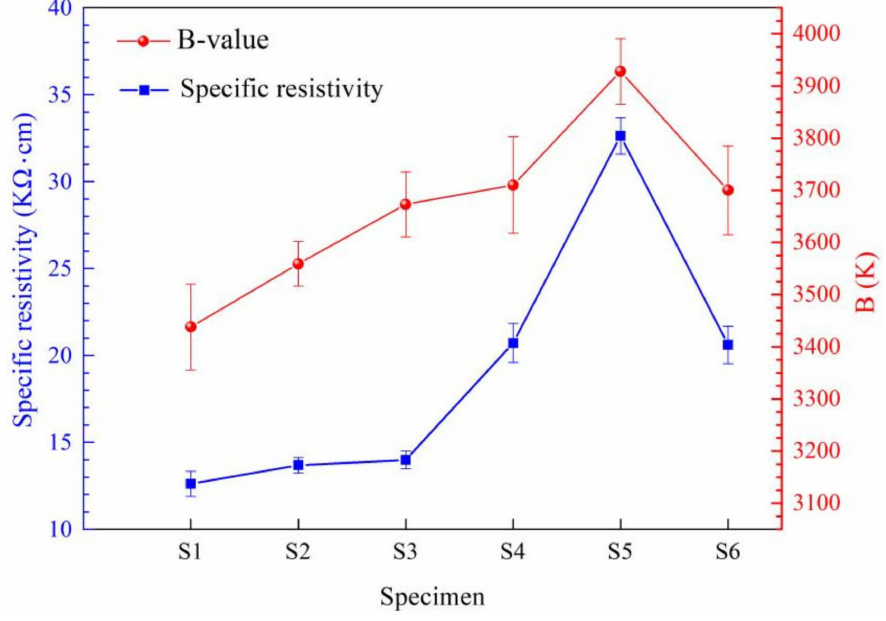
Figure 10. The resistivity and B-values of the sintered samples of